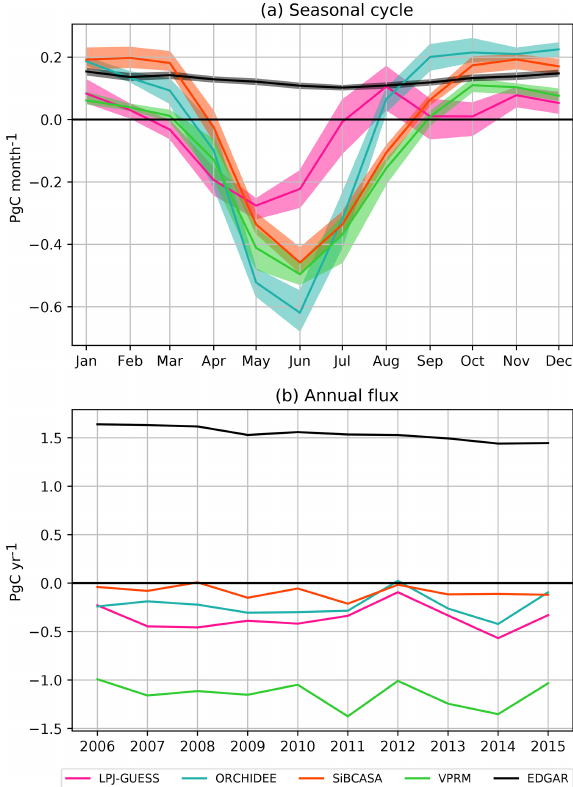
Figure 2. Seasonal cycle (a) and inter-annual variability (b) of the prior NEE (coloured lines/shading) and prescribed anthropogenic flux (black) used in the inversions, for geographical Europe (see definition in Sect. 3). The solid lines in the upper plot represents the mean seasonal cycle over the 10 years of the study, while the shaded envelopes show the minimum and maximum values over the same